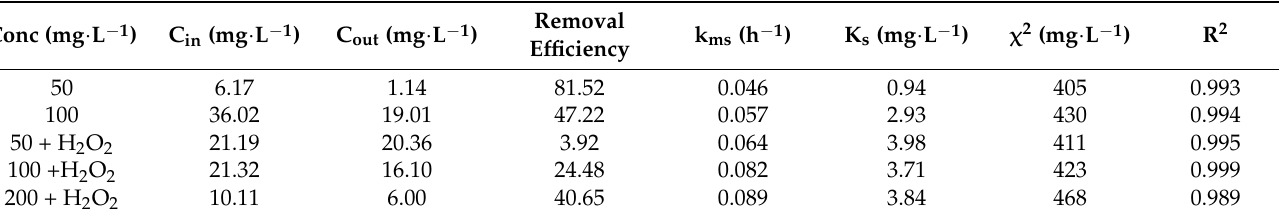
Table 3. Kinetic parameter estimation for the biological reactor at different initial concentrations using measured data (Michaelis–Menten